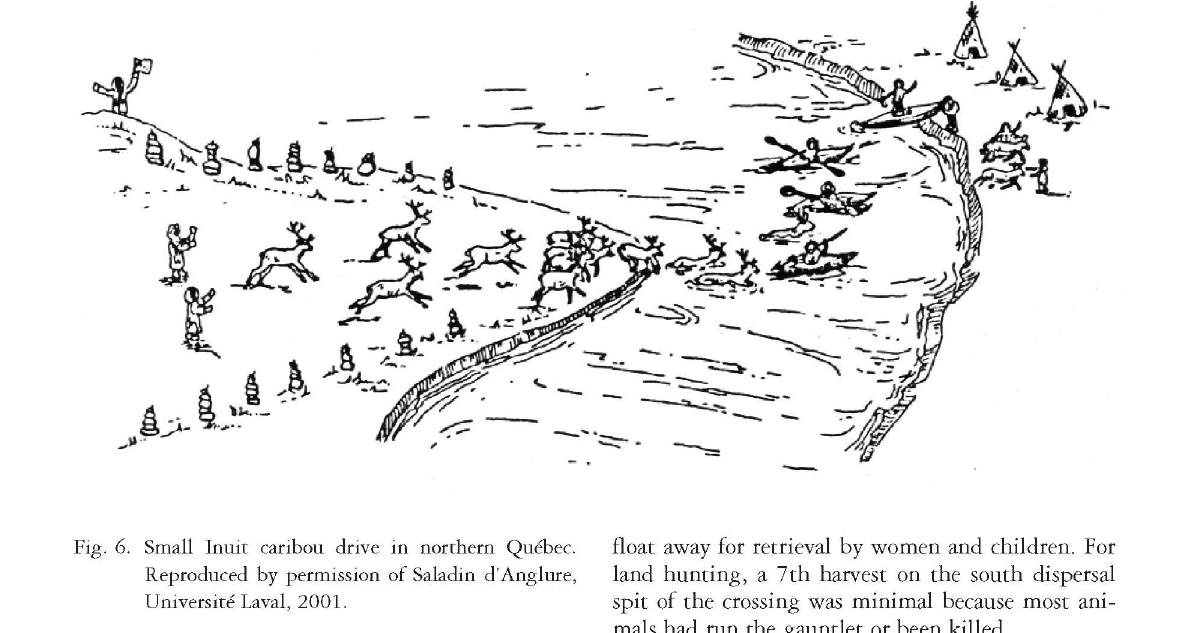
Fig. 6. Small Inuit caribou drive in northern